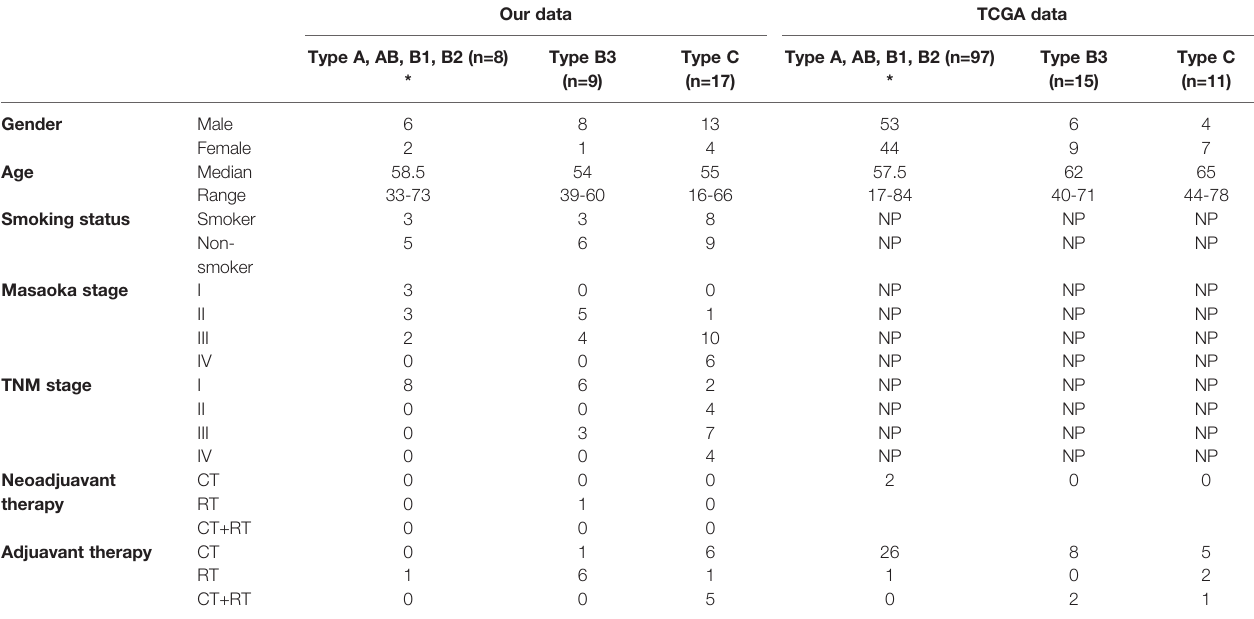
TABLE 1 | Clinicopathological characteristics of study population from TCGA and our